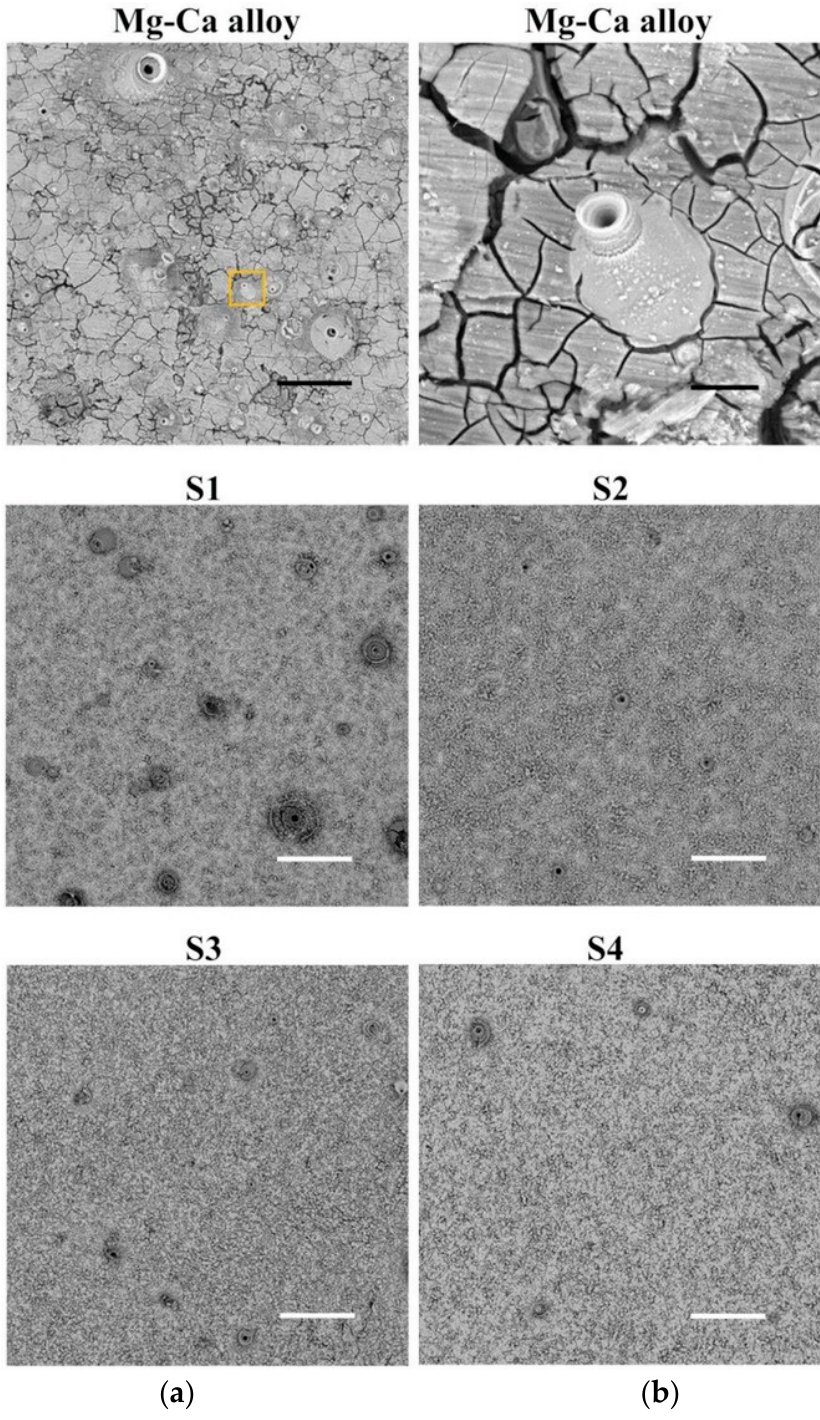
Figure 3. SEM images of coated and uncoated Mg–Ca alloys after the electrochemical tests: Mg–Ca alloy ( a ) 100 µm, crater-like formation on Mg–Ca alloy( b ) 10 µm. TCP coated Mg–Ca: S1 (Tsubstrate = RT; Npulse = 12.000), S2 (Tsubstrate = 300 °C; Npulse = 12.000), Fe-TCP coated Mg–Ca S3 (Tsubstrate = RT; Npulse = 6.000) and S4 (Tsubstrate = 300 °C; Npulse = 6.000). All films were deposited with a ns laser source operating at λ = 355 nm, ϕ = 2 J·cm − 2 , d = 4 cm. In S1, S2, S3 and S4 images the scale bar is 100 µm. Reproduced with permission from [101], copyright from 2020 WILEY-VCH Verlag GmbH & Co. KGaA, Weinheim.